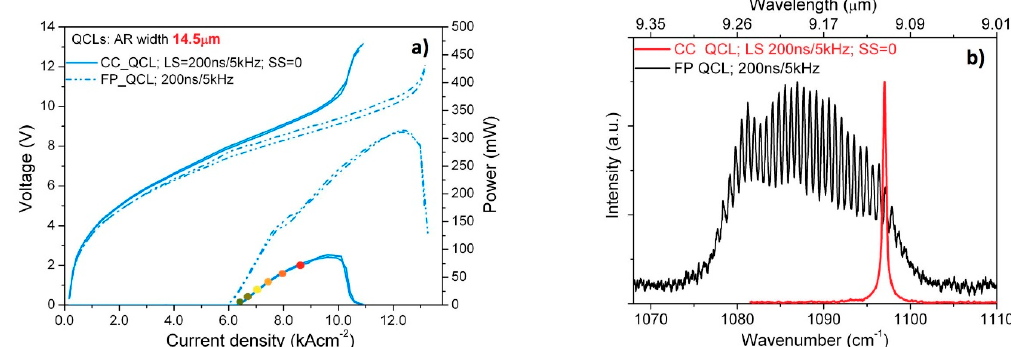
Figure 5. Comparison of L–I–V curves of RIE fabricated CC-QCLs (solid line) and FP QCL (dash-dot line) ( a ); comparison of emission spectra of CC-QCL and FP QCL at the constant current density/the same values of supplied current density 7.3 kA/cm 2 ( b ).